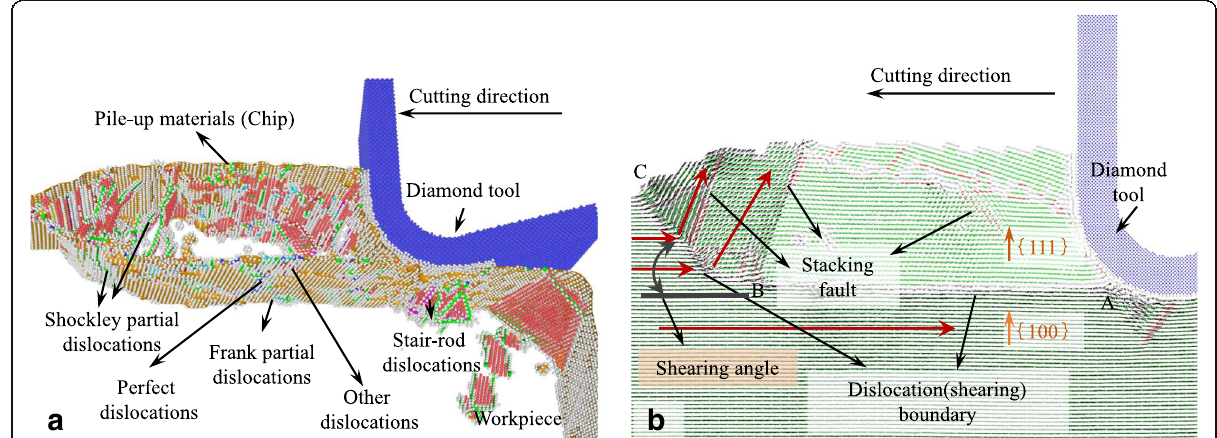
Fig. 4 a Snapshots of the microstructure evolution at cutting direction of {100}<012>, b displacement vector sliced at 4 nm in z